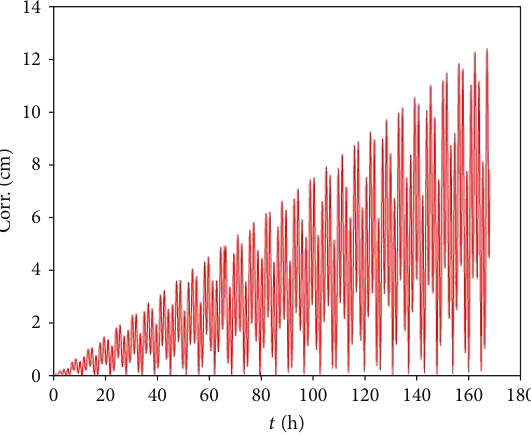
Figure 8: Total p-N corrections versus the time with TOL and TOL =10 − 16 . a